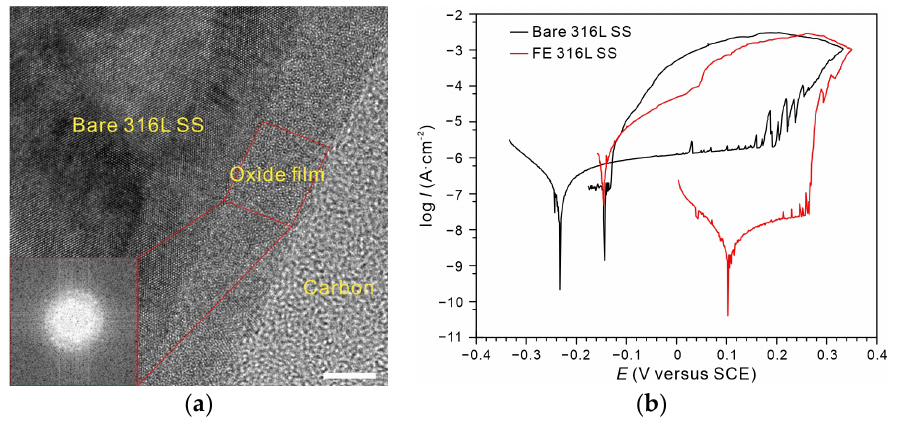
Figure 2. ( a ) Cross-sectional HR-TEM image of the modified oxide film on 316 L SS (Scale bar, 5 nm). ( b ) Polarization curves of bare 316 L SS (black) and FE 316 L SS (red) with a reverse scan in 0.6 M NaCl solution (25 °C).